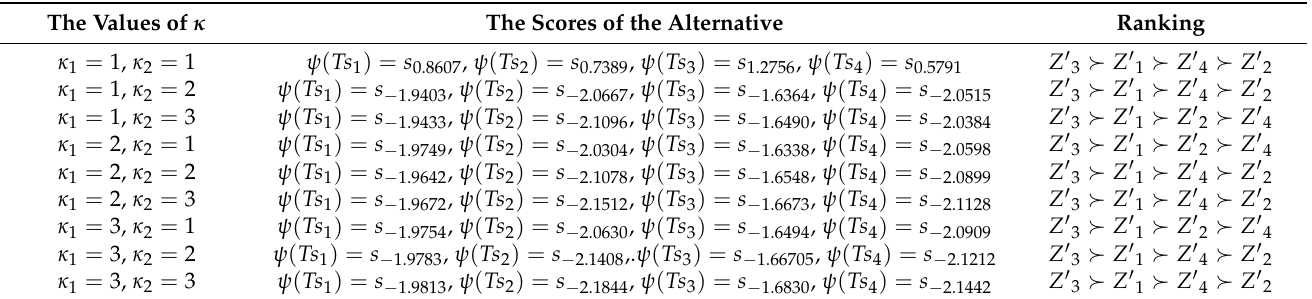
Table 2. Ranking of the alternatives based on the PLPMSM operator for the different alternatives. The Values of κ The Scores of the Alternative Ranking κ 1 = 1, κ 2 =